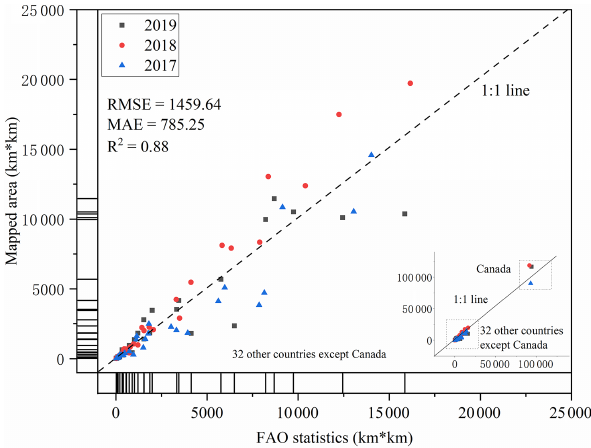
Figure 7. Comparison of rapeseed areas with FAO statistics at the national level.